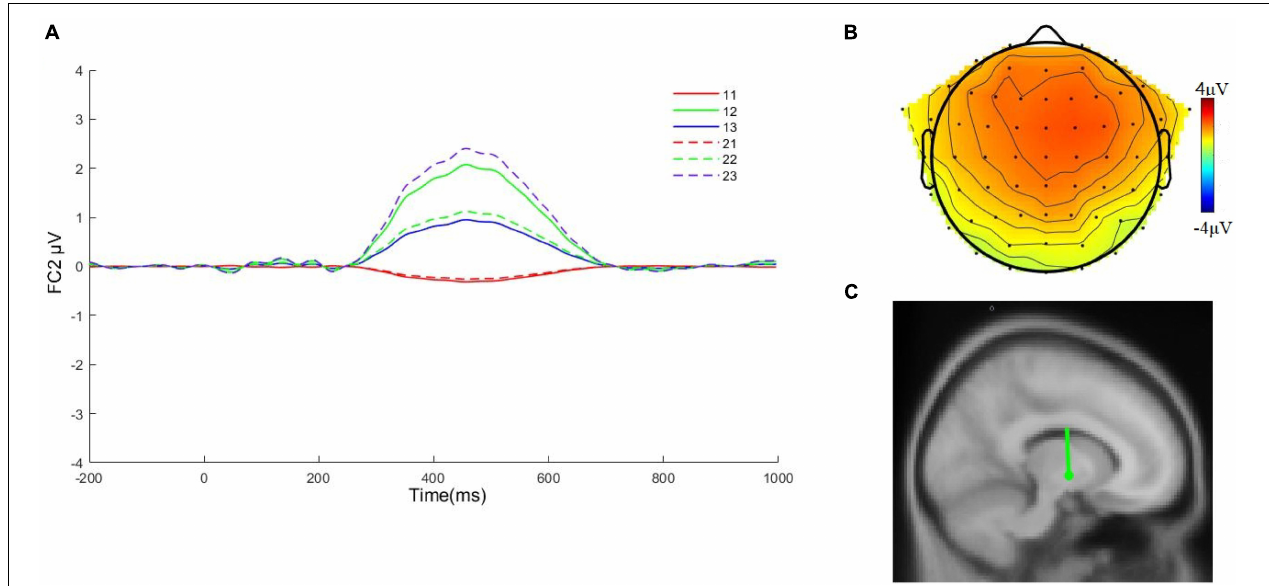
FIGURE 4 | (A) The average waveform of P3 at FC2 for six conditions. 11: ingroup, extremely unfair; 12: ingroup, moderately unfair; 13: ingroup, fair; 21: outgroup, extremely unfair; 22: outgroup, moderately unfair; 23: outgroup, fair. (B) Topography of deaf college students in the face of fair conditions. (C) The dipole source associated with time factor 1/spatial factor 1